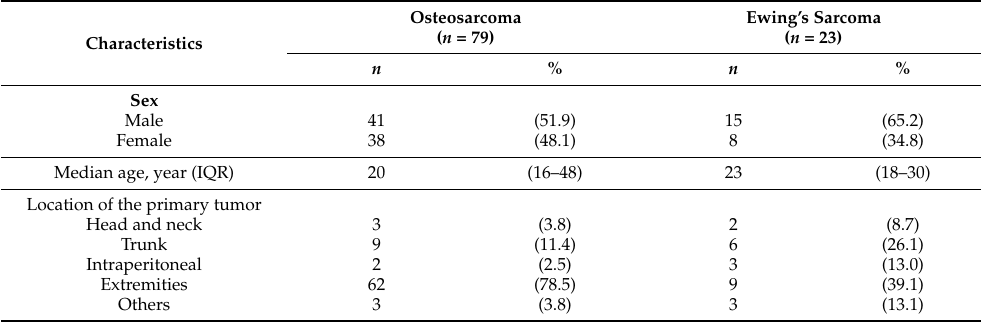
Table 1. Patient